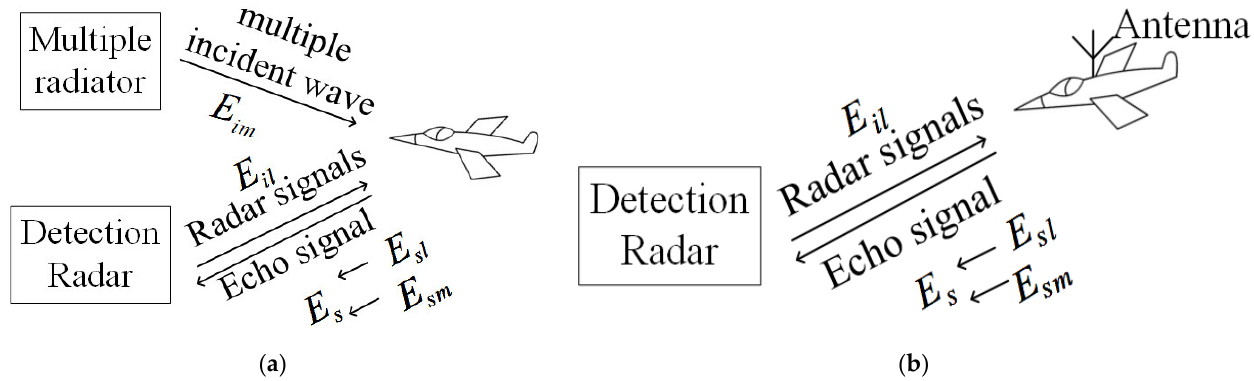
Figure 1. Two different ARCS cases ( a ) target illuminated by radar and multiple radiators ( b ) target illuminated by radar and antenna.